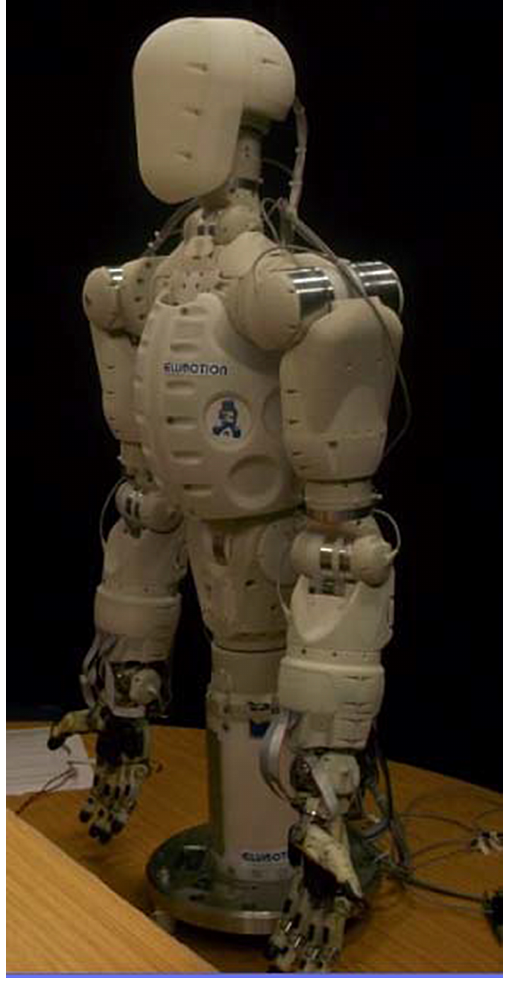
Figure 2. Bristol Robotics Laboratory BERT II robot.